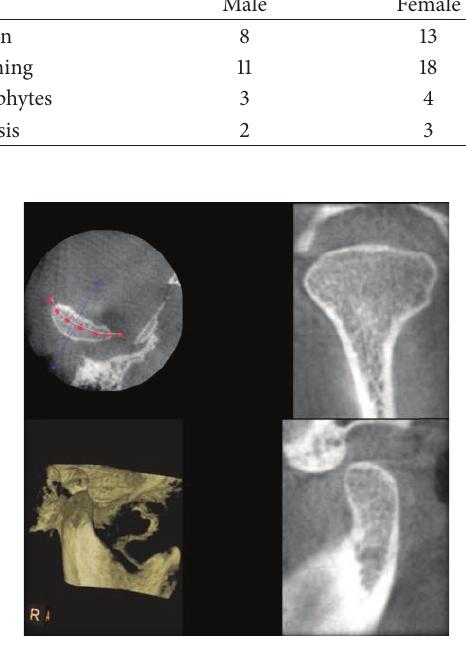
Figure 5: Flattening of condyle as seen in DVT.